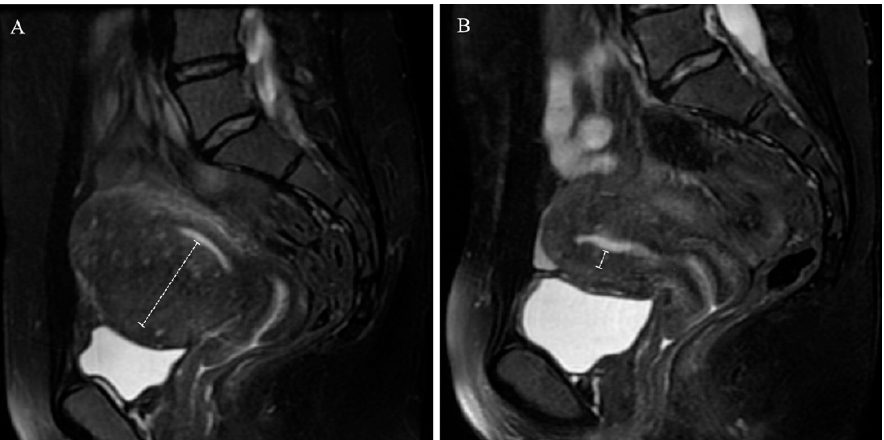
Figure 1. In diffuse adenomyosis, the JZ is irregular or only visible in the isthmus of the uterus, and the other parts are replaced by adenomyotic lesions. Therefore, we introduced the term “JZ max-A ” instead of using JZ. All low-intensity signal areas representing diffuse circumscribed adenomyosis attached to the JZ are included in JZ max-A . ( A ) Preoperative JZ max-A , ( B ) postoperative JZ max-A , JZ = junctional zone.